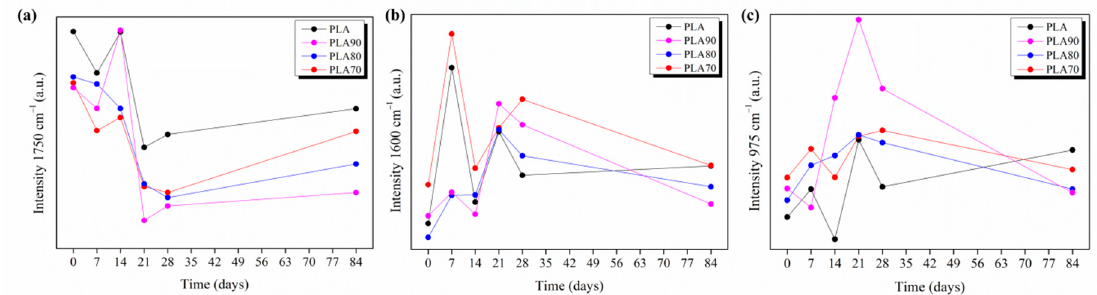
Figure 6. Evolution of intensity of 1750 cm − 1 ( a ), 1600 cm − 1 ( b ) and 975 cm − 1 ( c ) peaks for neat PLA and each of the PLA:OLA electrospun samples by increasing the degradation days in PBS.